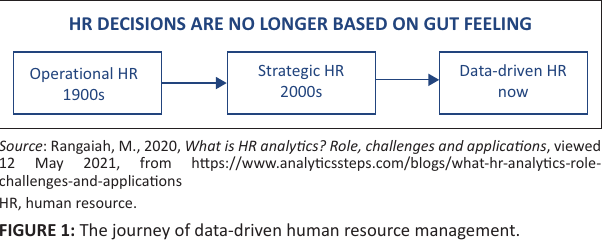
Figure 1 outlines the journey from traditional HRM to data- driven HRM.